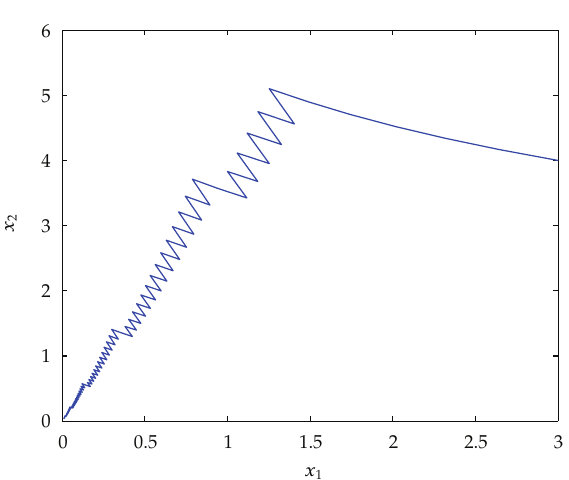
Figure 1: The state of the switched system in